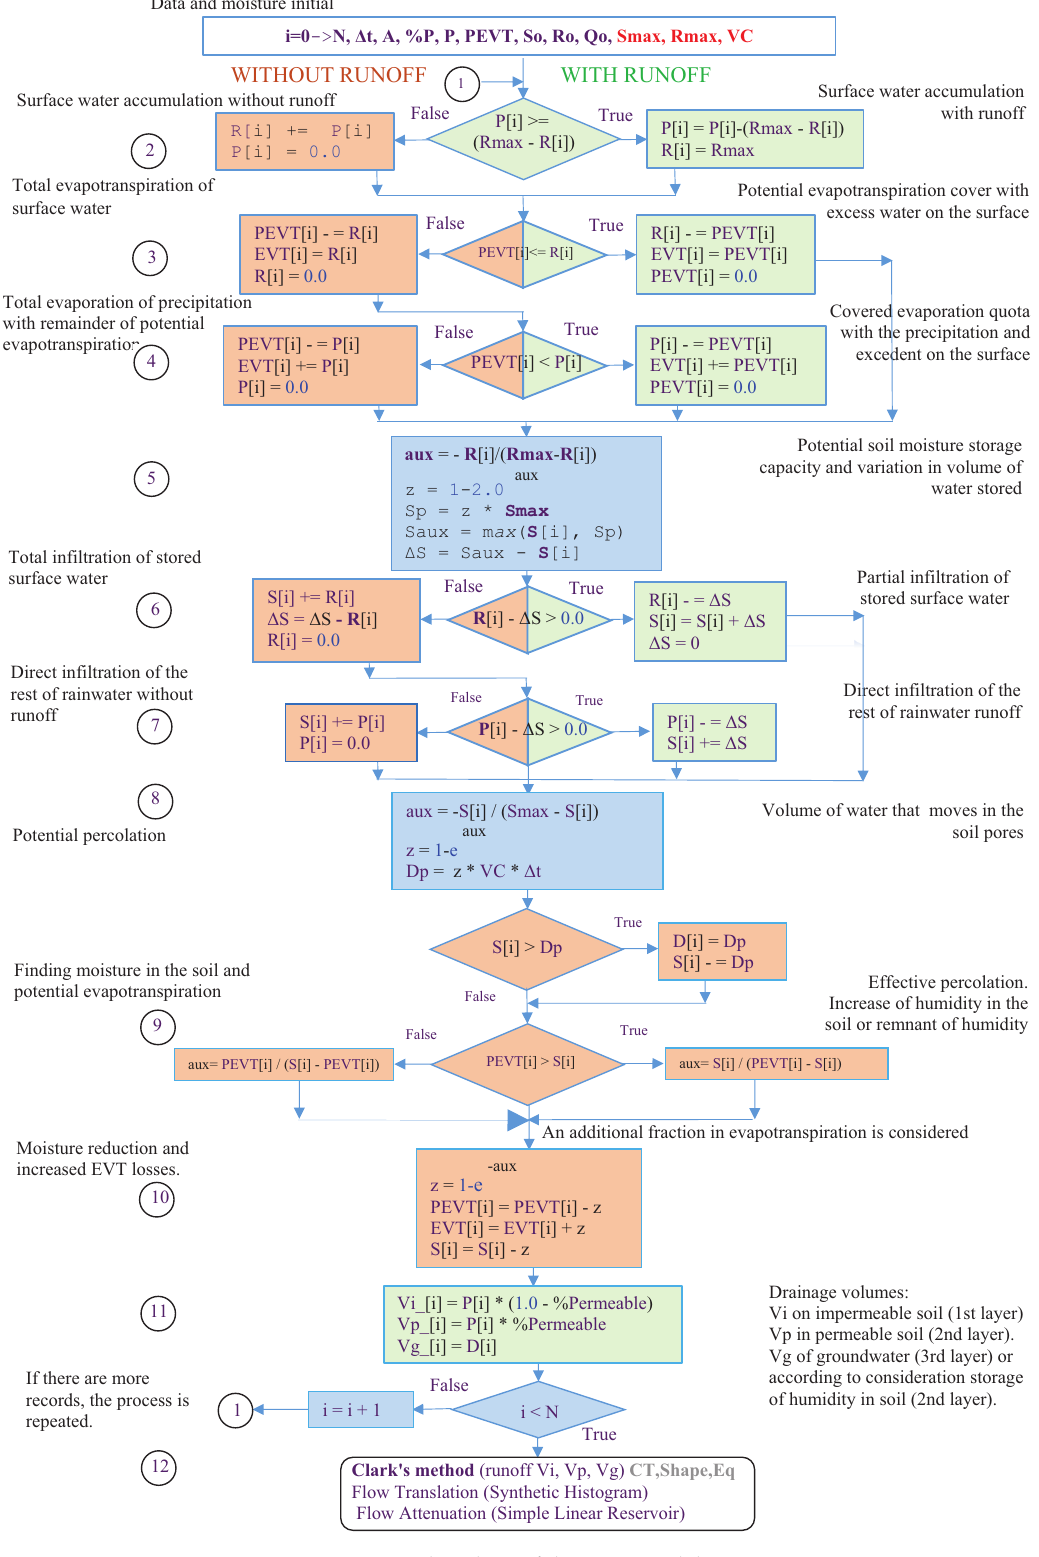
Figure 2. Flowchart of the Qom